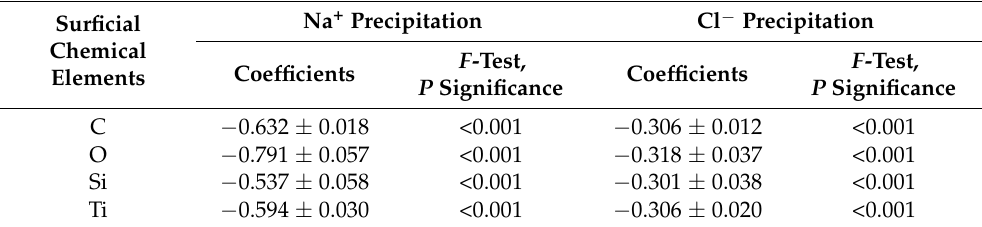
Table 6. Regression coefficients for chemical elements in a-C:H:SiO x film surface after five-week immersion in 0.9% NaCl solution, X ±